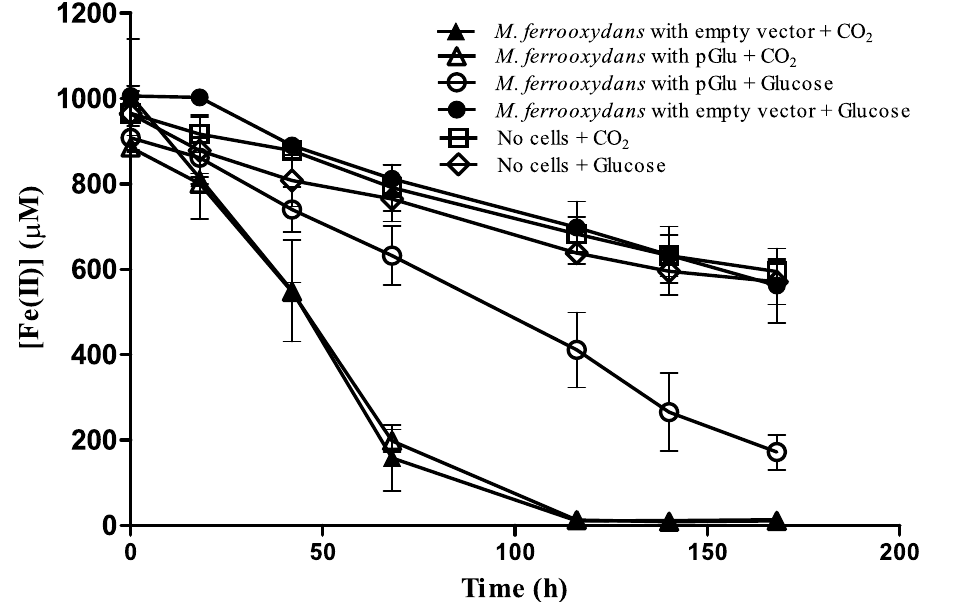
Figure 4. Fe(II) oxidation rate of M. ferrooxydans containing pGlu. Fe(II) quantification over time for M. ferrooxydans containing pGlu (open symbols) and M. ferrooxydans containing empty vector pRK2m3 (closed symbols) grown on either glucose (o, ) or carbon dioxide (∆, ▲ ) as the sole carbon source. Fe(II) was ●